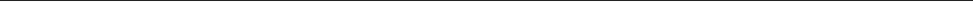
Table 1. Effect of topical application of forty compounds on adult female Anopheles gambiae . Knock down and mortality was observed 60 minutes and 24 hours after topical application, respectively, and were corrected for negative control mortality using Abbott’s formula (Abbott, 1925). UN denotes a compound listed by IRAC (2018) with unknown or uncertain mode of action. Compounds indicated as being unclassified have not been listed by IRAC (2018). ND indicates a data point which was not